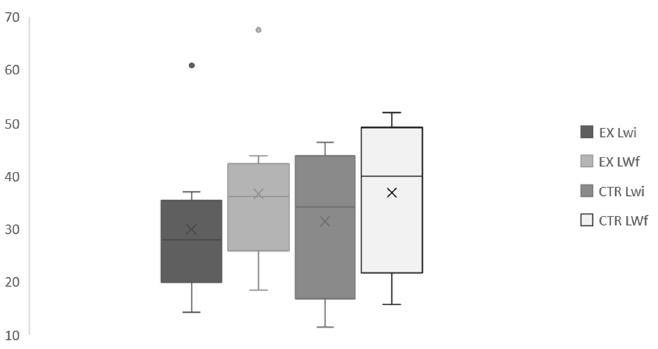
Figure 8. Bitches body live weight at the beginning and at the end of pregnancy. EX: experimental; CTR: control; LW i : initial body weight; LW f : body weight after delivery.